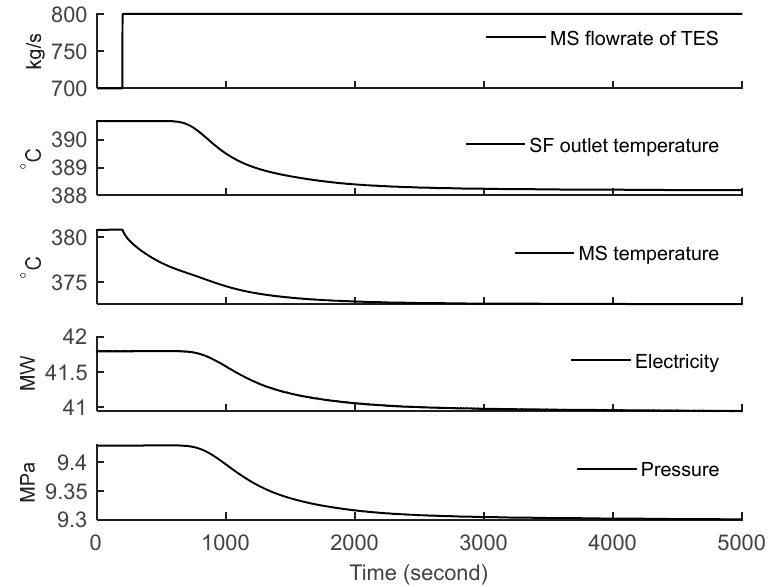
Figure 5. System response to step change of MS flowrate of TES.